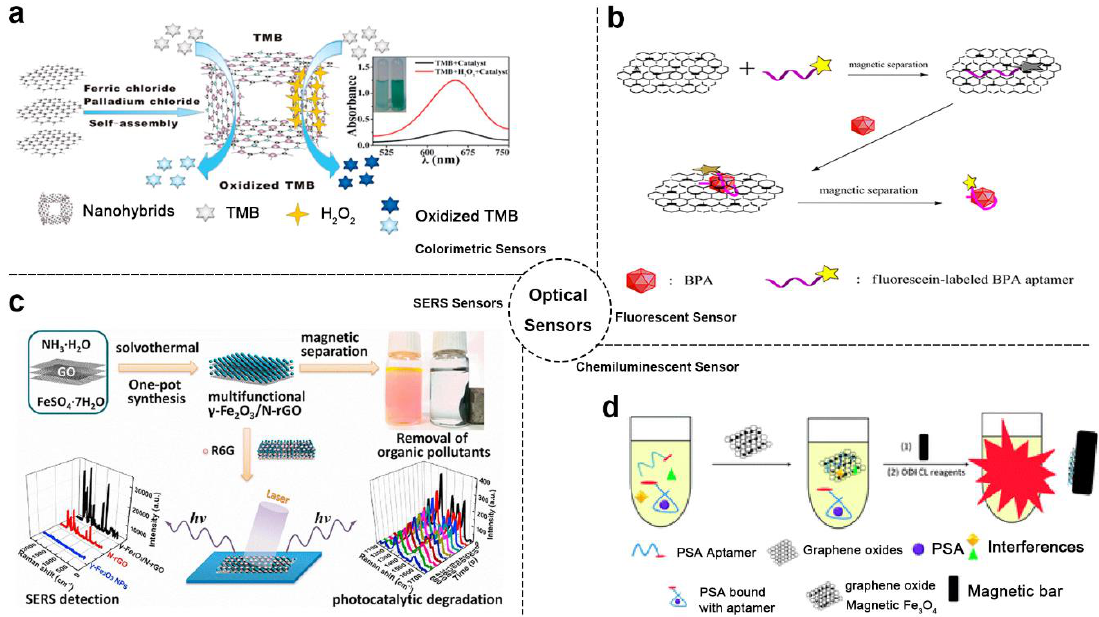
Figure 1. Optical sensor-based MGCs: ( a ) Schematic diagram of colorimetric sensor example. Adapted with permission from ref. [32]. Copyright © 2015, American Chemical Society; ( b ) Schematic diagram of fluorescent sensor example. Adapted with permission from ref. [35]. Copyright © 2014, American